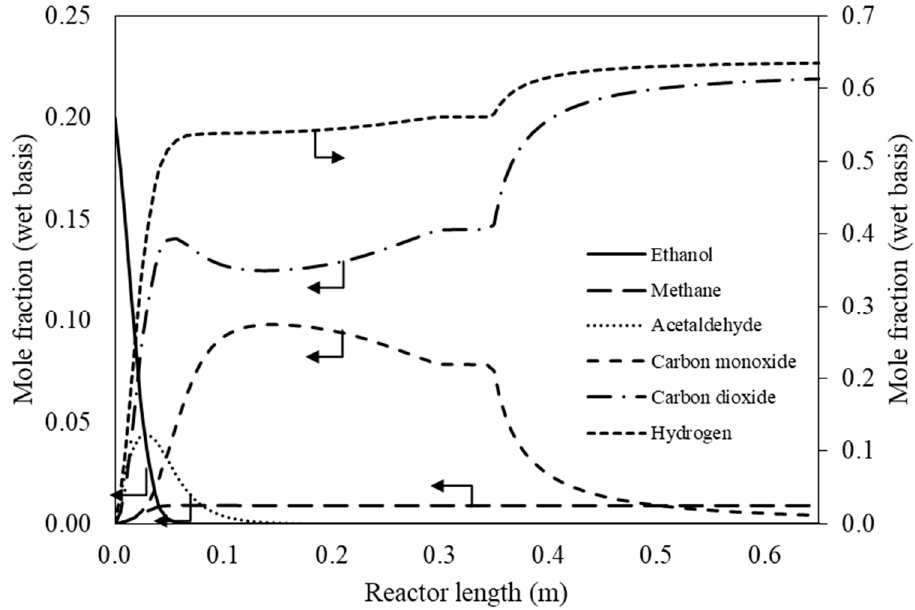
Figure 11. Mole fraction profiles at the center along CHIRS (II).